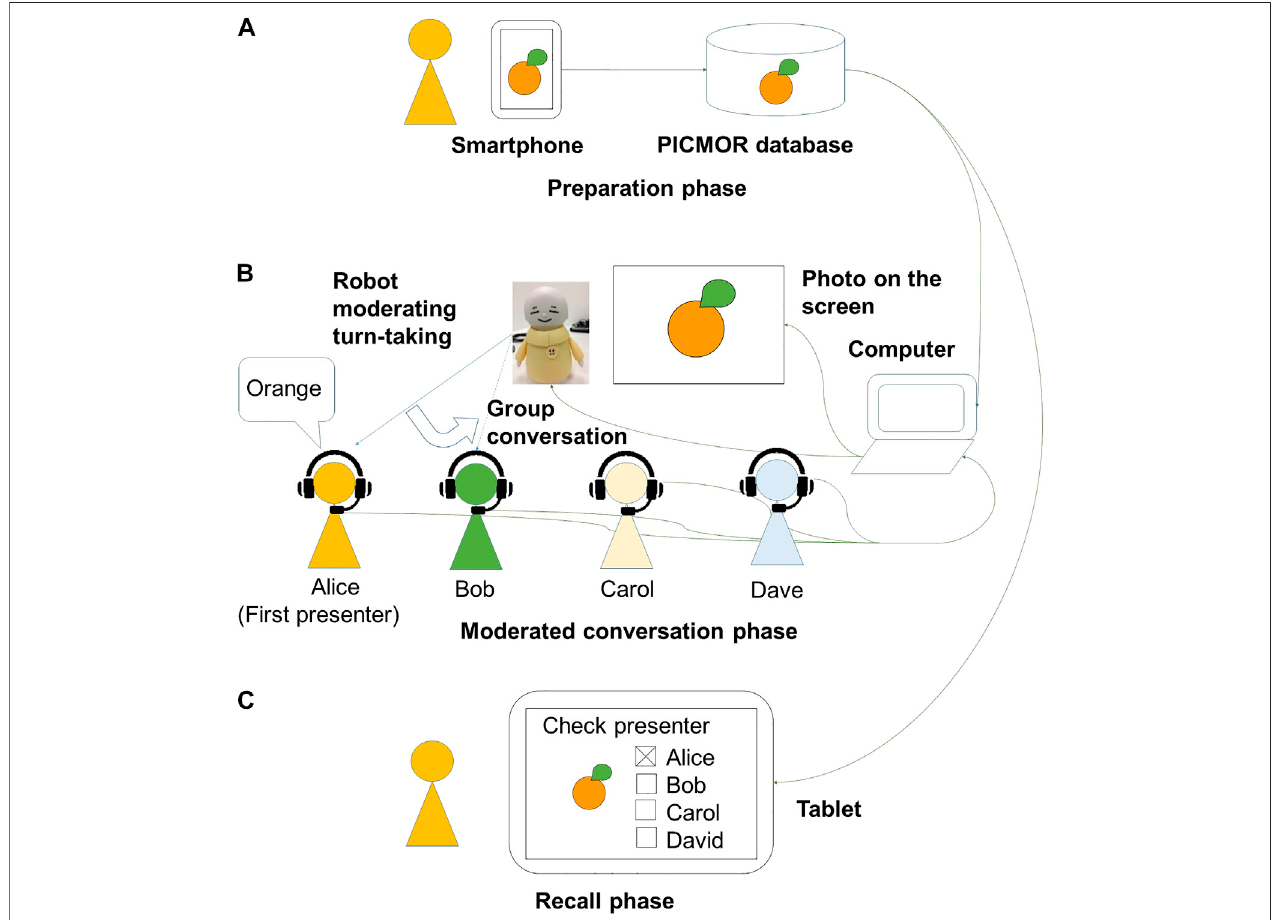
FIGURE 2 | Experimental setup for Photo-Integrated Conversation Moderated by Robots (PICMOR).